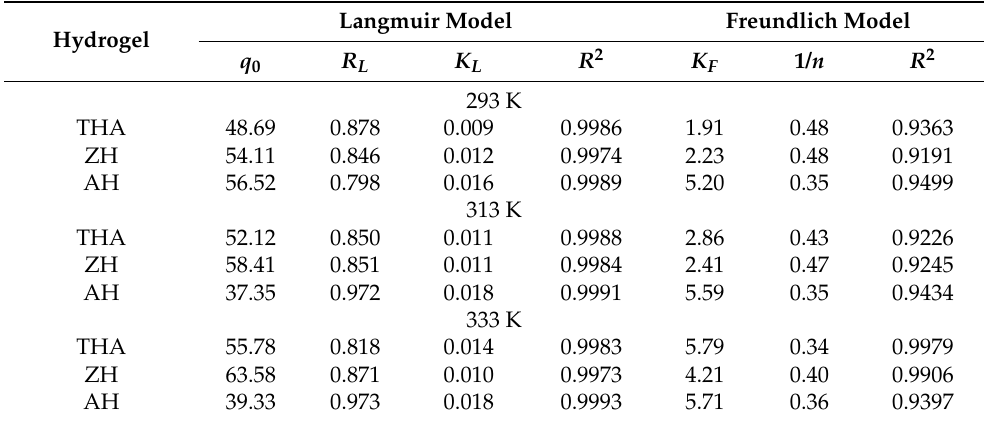
Table 4. The comparison of the maximum adsorption capacities of THA, ZH and AH for the Zn(II) complexes with EDDS. Langmuir Hydrogel